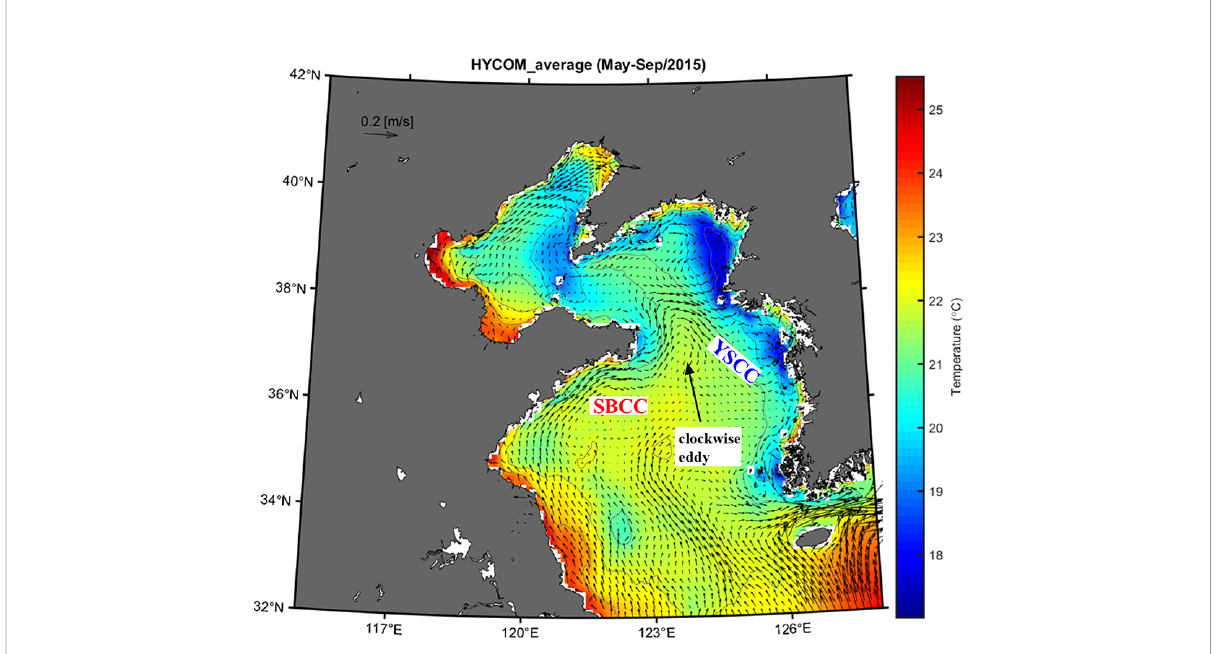
FIGURE 2 The distribution of averaged ocean current and water temperature during May to September in the Yellow Sea and Bohai Sea. Generated from